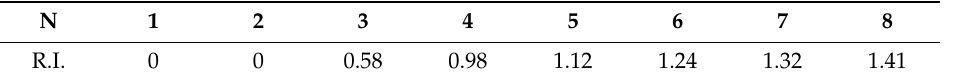
Table 2. Random Index